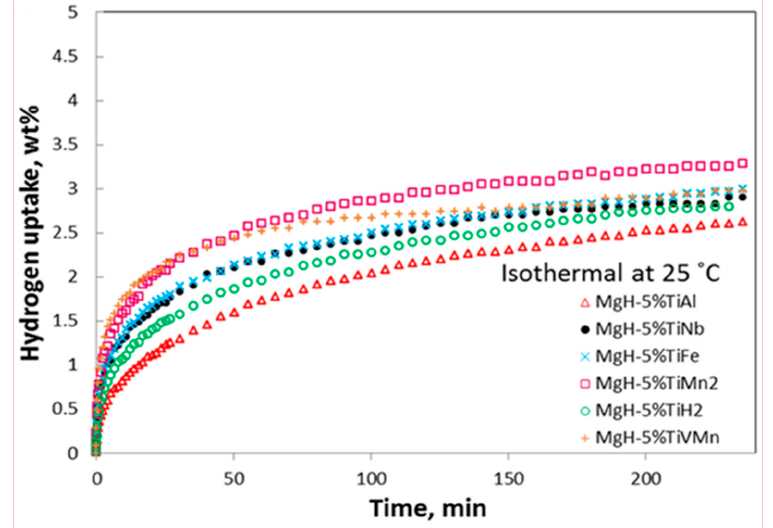
Figure 5. E ff ect of Ti-based catalysts on hydrogenation kinetics under hydrogen pressure of 1 bar [179].